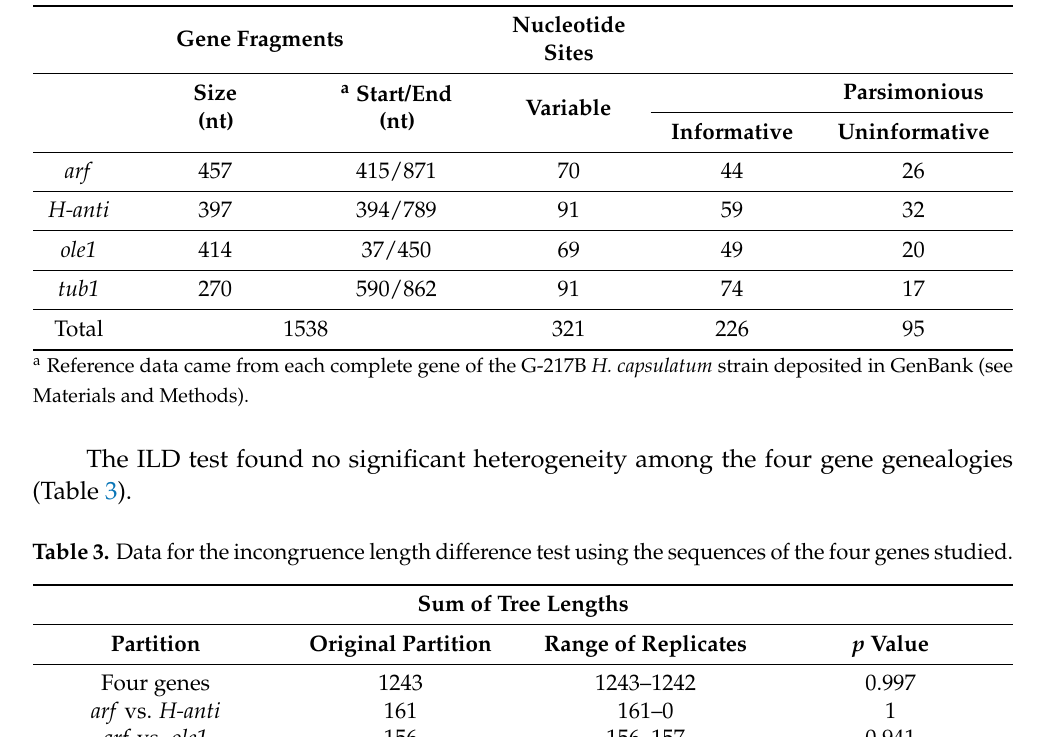
Table 2. Genetic diversity of each gene fragment analyzed.